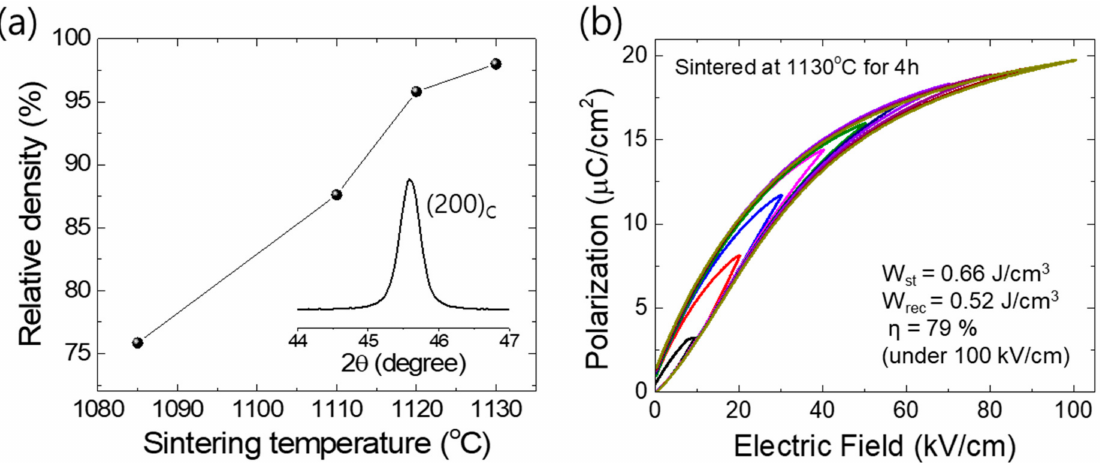
Figure 7. ( a ) Relative density of the x = 0.000 specimen sintered at various temperatures for 4 h. Inset of ( a ) shows the XRD pattern of the (200) C peak of the x = 0.000 specimen sintered at 1120 ◦ C. ( b ) Unipolar P-E curves of the x = 0.000 specimen sintered at 1130 ◦ C for 4